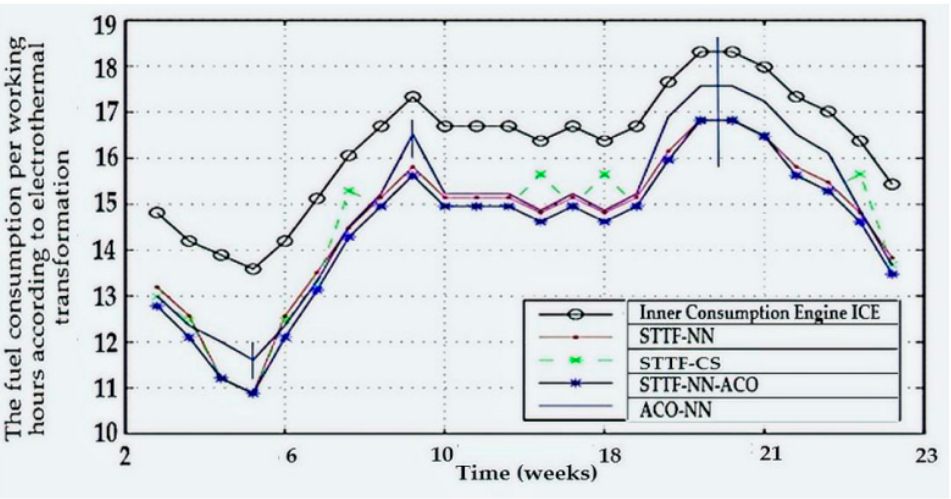
Figure 22. The daily fuel consumption for TEG-ICE is affected by the cracks’ prediction and rein- stalling the thermal conductors in places far away from cracked positions.